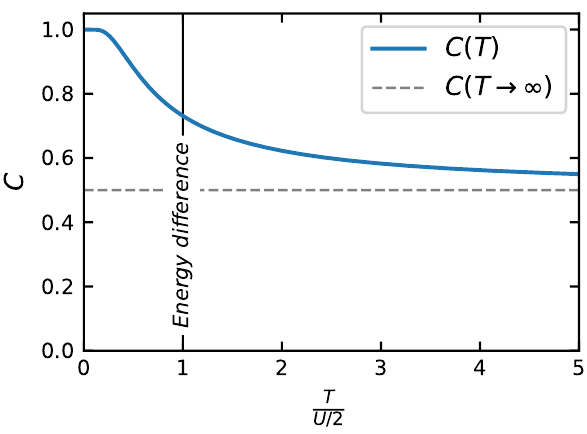
Figure 12: Temperature dependence of the long-term memory coefficient C for the local spin-susceptibility in the atomic limit for µ = U /